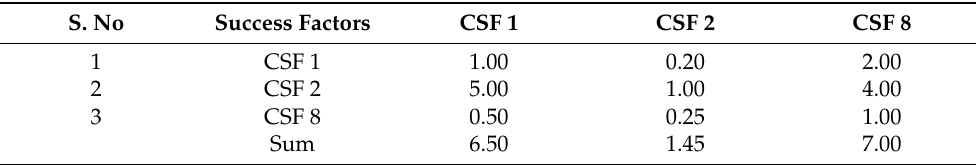
Table 16. Pairwise comparisons for preparation level success